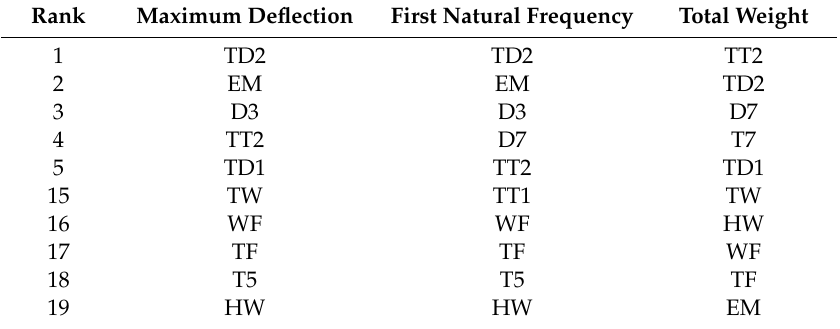
Table 5. The ranks of the sensitive design parameters for the maximum deflection, the total weight, and the natural frequency. Rank Maximum Deflection First Natural Frequency Total Weight TD2